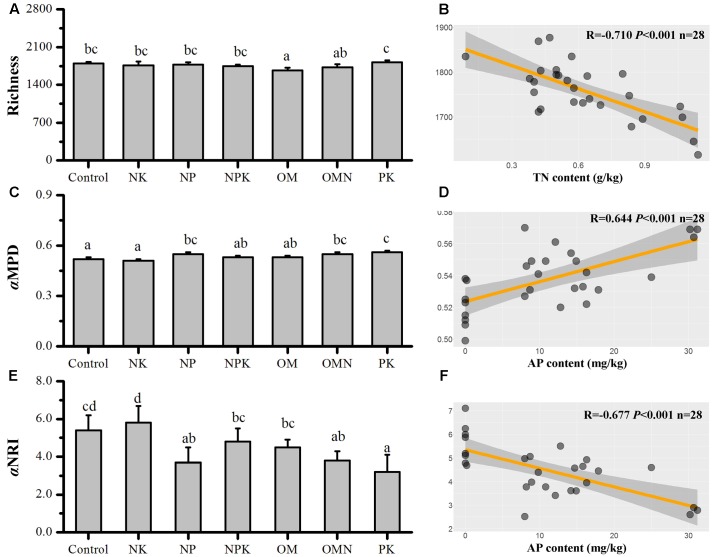
Changes in bacterial Richness (A), αMPD (C), and αNRI (E) in response to different fertilizations. And the respective highest correlations (from Table 1) to soil chemical factors for Richness (B), αMPD (D), and αNRI (F). Lettering denotes significant differences between fertilizations.